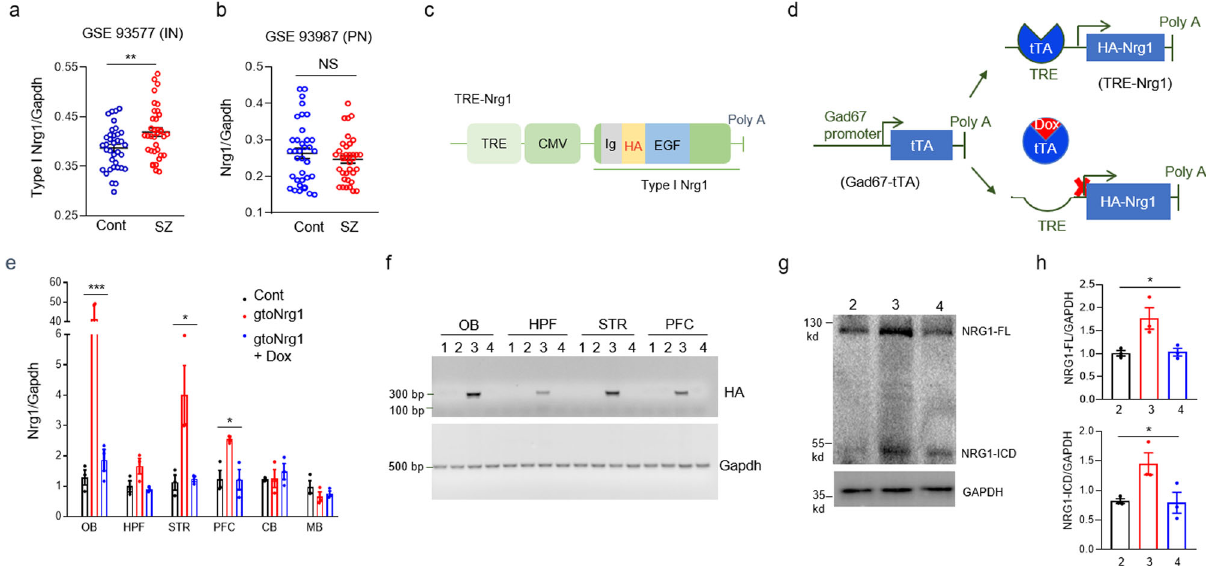
Fig. 1 Generation of gto Nrg1 mice to mimic increased Nrg1 expression in GABAergic interneurons from schizophrenia patients. a Increased type I Nrg1 mRNA levels in GABAergic interneurons from schizophrenia PFC, compared with age- and sex-matched controls. ** P = 0.0064, two-sided t test, n = 36 for each group. Data are presented as mean values + / − SEM. b Similar Nrg1 expression in pyramidal neurons from layer 3 PFC between control and schizophrenia patients. NS, not signi fi cant, two-sided t test, n = 36 for each group. Data are presented as mean values + / − SEM. Cont control, SZ schizophrenia, IN GABAergic interneurons, PN pyramidal neurons. The levels of Nrg1 mRNA were normalized to that of Gapdh. c Full-length Nrg1 type I β 1a was cloned in pMM400 between the promoter complex of TRE and CMV (cytomegalovirus minimal promoter) and SV40 polyadenylation (Poly A) signal. An HA tag was inserted between the Ig and EGF domain of NRG1. d The principle of the tet-off system. HA- Nrg1 is expressed in Gad67 -tTA; TRE- Nrg1 (gto Nrg1 ) mice. The expression of HA- Nrg1 can be switched off by Dox. e Increased Nrg1 mRNA levels in different brain regions of gto Nrg1 mice. The Nrg1 mRNA levels return to normal after Dox treatment for 5 days. * P (PFC) = 0.0157, * P (STR) = 0.0223, *** P = 0.001, one-way-ANOVA, n = 3 mice for each group. Data are presented as mean values + / − SEM. OB olfactory bulb, HPF hippocampus formation, STR striatum, PFC prefrontal cortex, CB cerebellum, MB midbrain. f Expression of HA tag in gto Nrg1 mice. Three independent experiments were repeated to get similar results. The homogenate from different brain regions was subjected to RT-PCR assay for HA and Gapdh. (1) TRE- Nrg1 ; (2) Gad67 -tTA; (3) gto Nrg1 ; (4) gto Nrg1 + Dox. g Increased NRG1 protein levels (including the full length and ICD) in the PFC of gto Nrg1 mice. The homogenate of PFC from different mice was subjected to western blot and probed with anti-NRG1 and anti-GAPDH Abs. (2) control; (3) gto Nrg1 ; (4) gto Nrg1 + Dox. h Quanti fi cation of the expression of full-length NRG1 (top) and NRG1- ICD (bottom) in panel g . * P = 0.0178 for NRG1-FL, * P = 0.034 for NRG1-ICD, one-way-ANOVA, n = 3 mice for each group, data were normalized to controls. Data are presented as mean values + / −